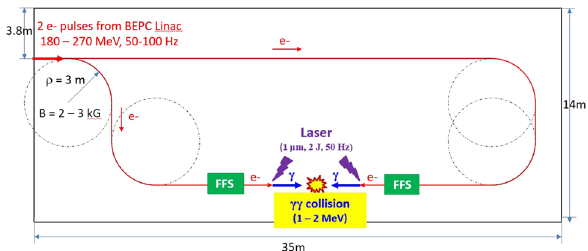
Fig. 2 A planned layout of the γγ collider facility in the IHEP exper- imental hall 10